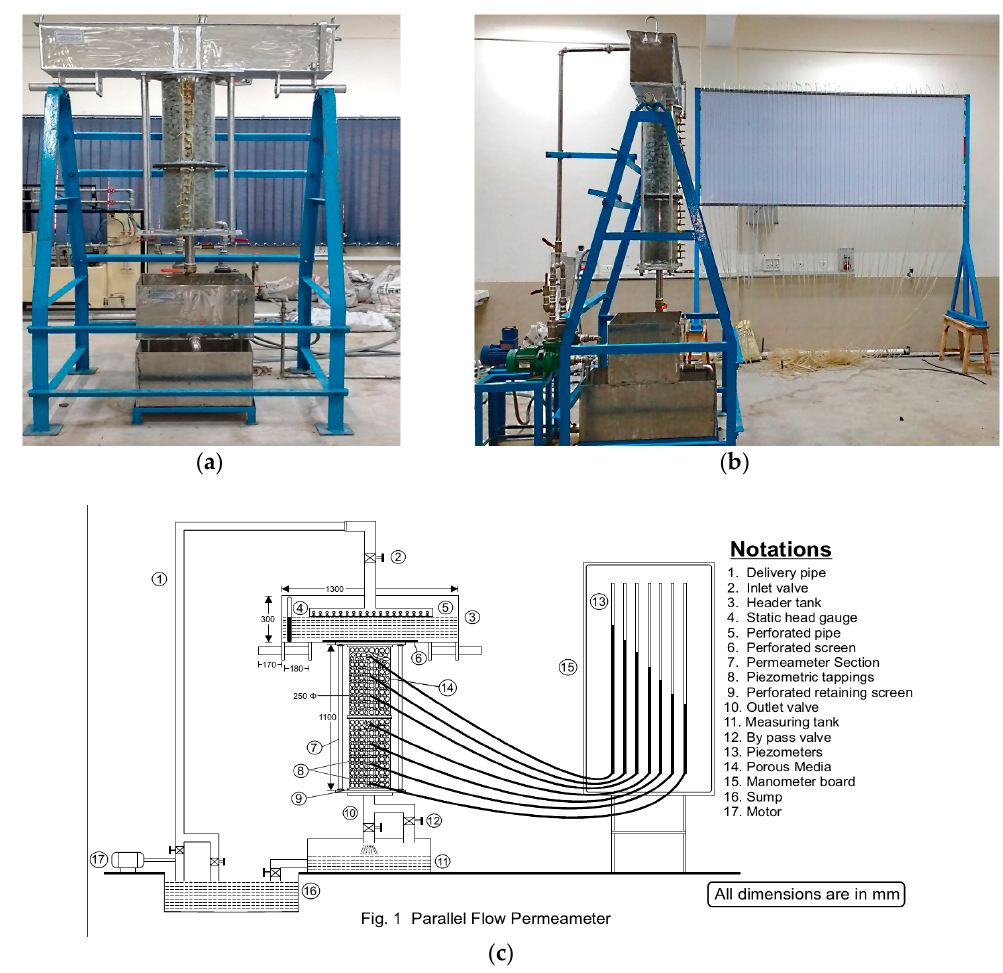
Figure 1. The experimental set-up with the parallel flow permeameter. ( a ) the front view; ( b ) the side view; and ( c ) the schematic diagram.